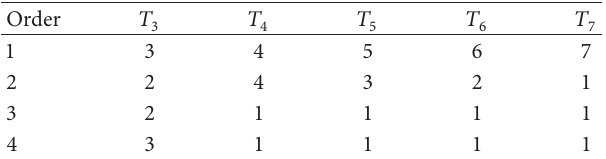
Table 4: Types of task number increase sequence (TNIS).